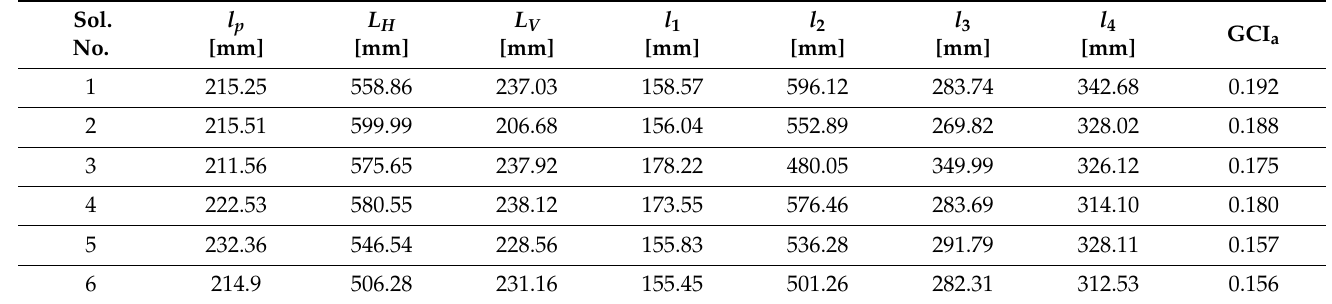
Figure 16. Mobile platform coordinates distribution density for the solution set SOLS(m) (m = 1, . . . , 28,568). Table 1. Results from the geometric optimization algorithm.